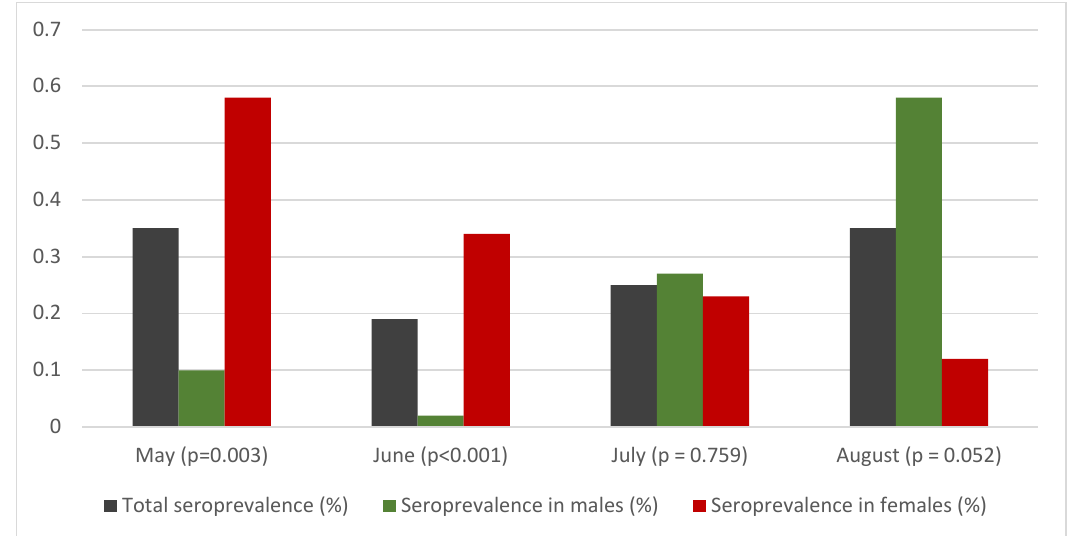
Figure 3. Total seroprevalence, and seroprevalence per sex from May to August 2020 ( p indicates the difference between sexes).